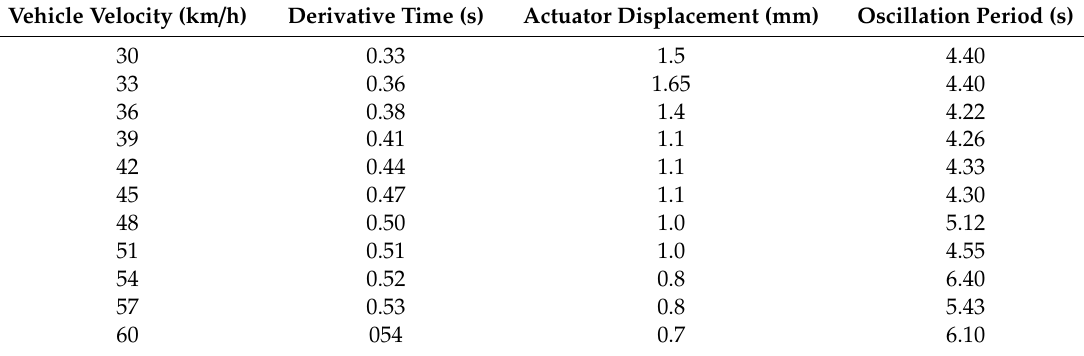
Figure 12. Example of simulation for inert driver siting before front axle of vehicle—( a ) hydraulic actuator displacement, ( b ) lateral displacement of front—1 axle and rear—2 axles, ( c ) yaw angular driver deviation, ( d ) hydraulic actuator displacement, ( e ) lateral displacement of front—1 axle and rear—2 axles, and ( f ) yaw angular driver deviation. Table 4. Simulation results of high-speed driving with an inert driver model and a driver at the front of the